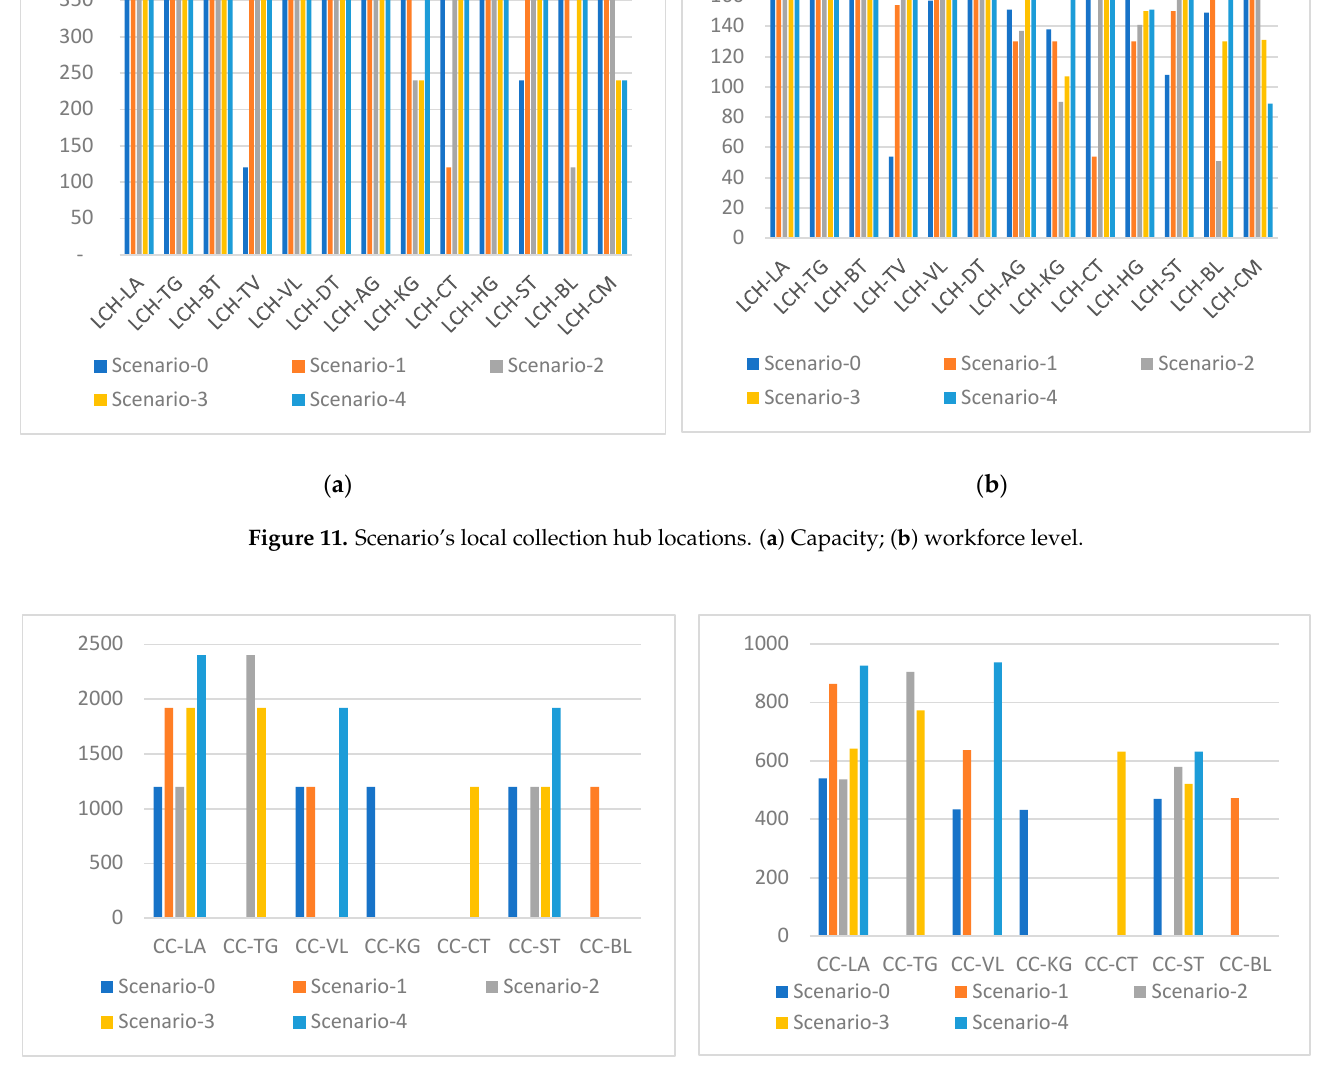
Figure 11. Scenario’s local collection hub locations. ( a ) Capacity; ( b ) workforce level.